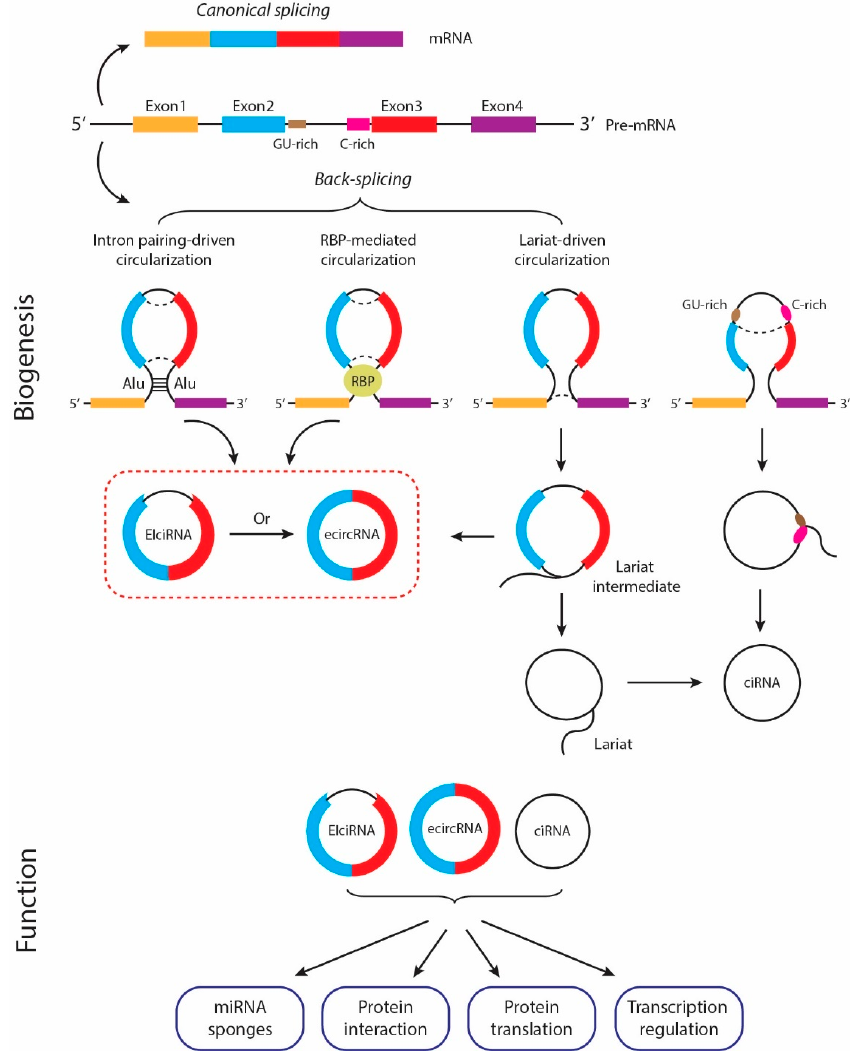
Figure 1. The biogenesis and functions of circRNAs. CircRNAs can be generated through multiple mechanisms. In the lariat-driven circularization model, a lariat is formed during pre-mRNA splicing to generate either ecircRNA, EIciRNA, or ciRNA. In the intron pairing-driven circularization model, the inverted complementary sequences between the upstream acceptor and downstream donor join via complementary base pairing, leading to the formation of EIciRNA or ecircRNA. In the RBP-driven model, some RBPs bring the acceptor and donor to proximity and promote circularization, resulting in the formation of EIciRNA or ecircRNA. CircRNAs exert their biological functions through several mechanisms. They can sponge miRNAs to inhibit their functions or interact with proteins directly to regulate their activity. Some circRNAs also translate functional proteins/peptides, or function in the nucleus by regulating their parental gene